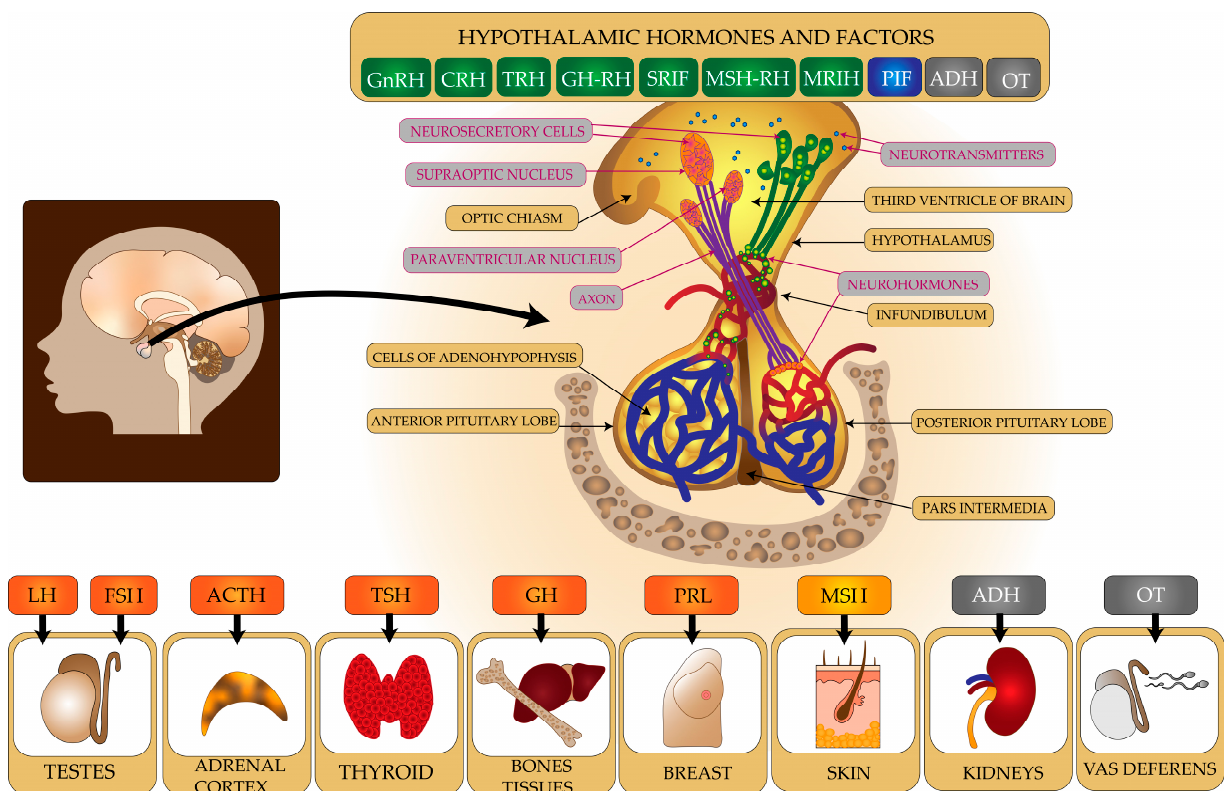
Figure 1. A diagram illustrating the relationships between the CNS and the endocrine